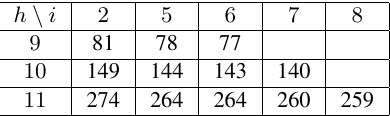
Tab. 1: Values of | W (1 , 1) ∩ W ( i, 0) | for i ∈ { 2 , 5 , . . . , h − 3 } , h = { 9 , 10 , 11 }